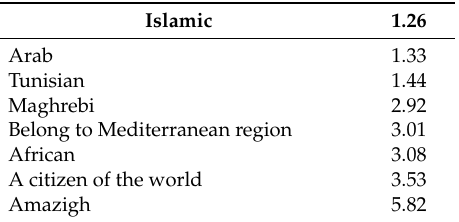
Table 10. Identification with different groups (mean scores: 1 = strongly agree, 7 = strongly disagree) ‘I am . . . ’.